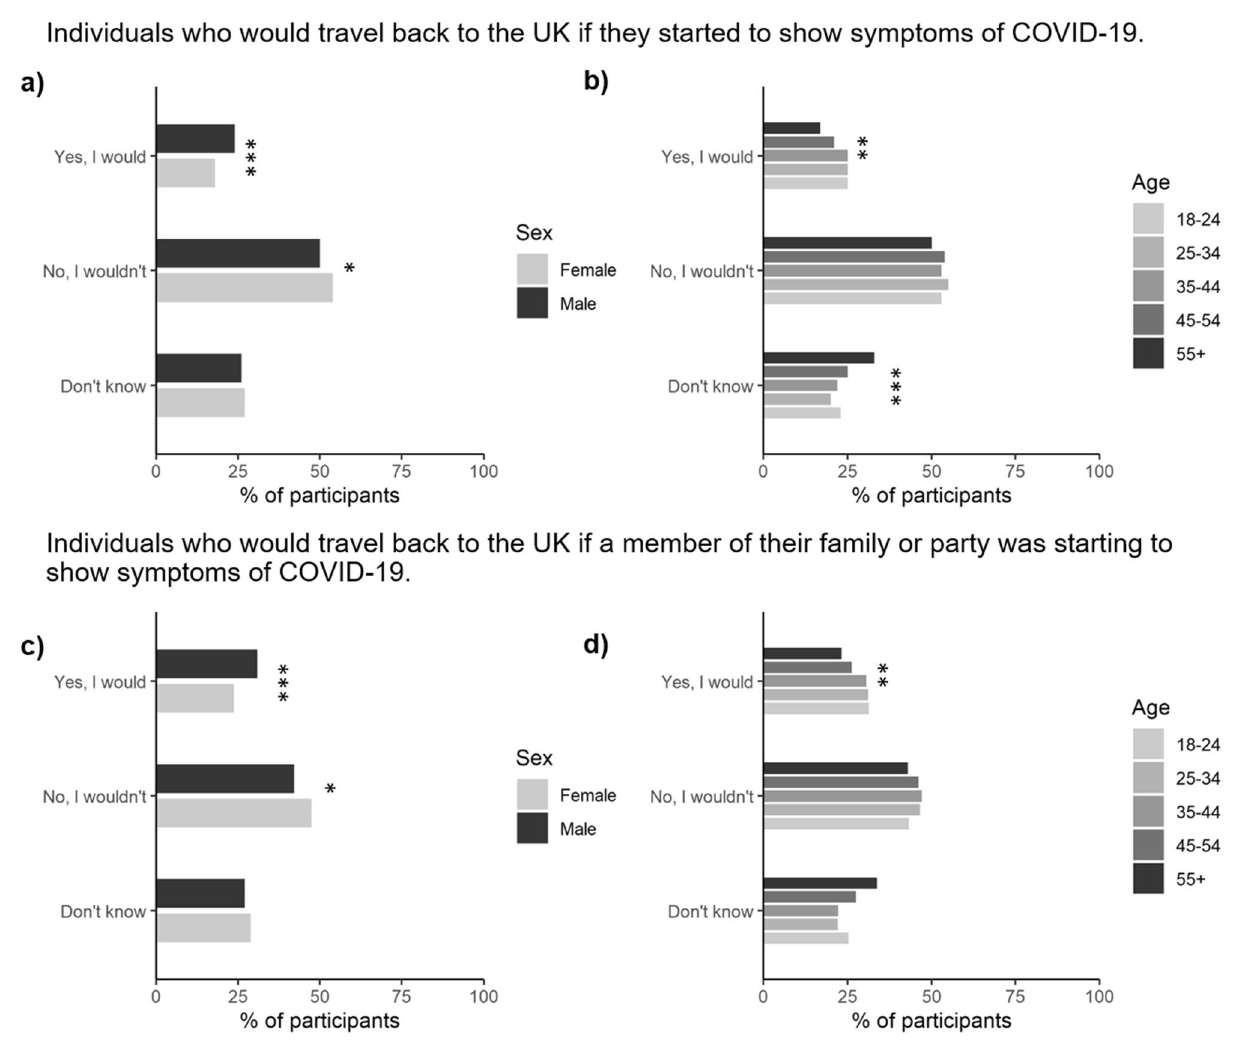
Figure 5. Proportion of participants stratified by either ( a ) gender, or ( b ) age ( n = 2103). *, **, and *** represent significant differences between the gender or age categories for a particular symptom at the P < 0.05, P < 0.01 or P < 0.001 level,